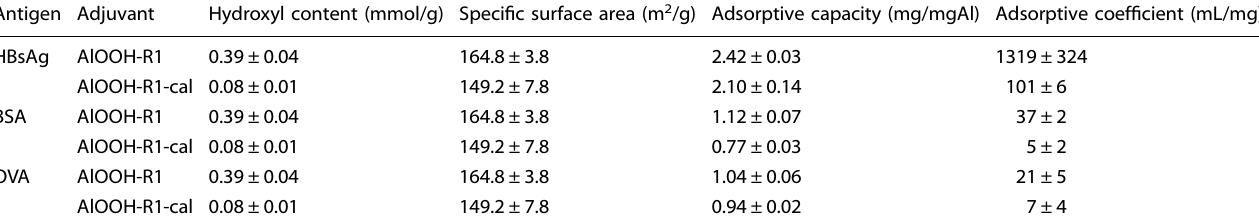
Table 3. Effect of speci fi c surface area and surface hydroxyl contents on the adsorptive capacity and adsorptive coef fi cient of HBsAg, BSA, and OVA by R1 and calcinated R1 nanorods.